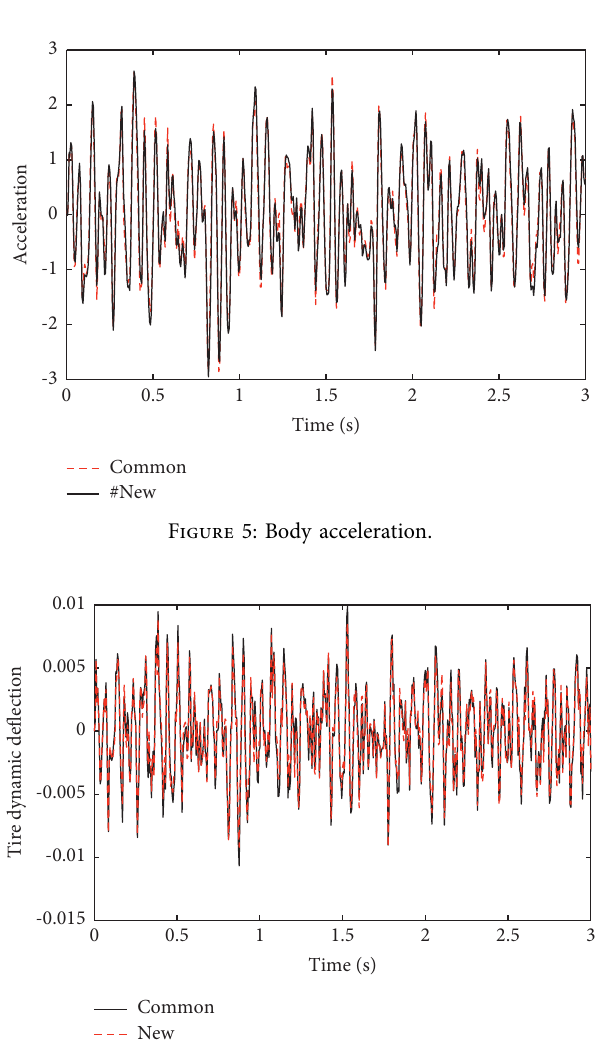
Figure 6: Dynamic displacement of the tire.